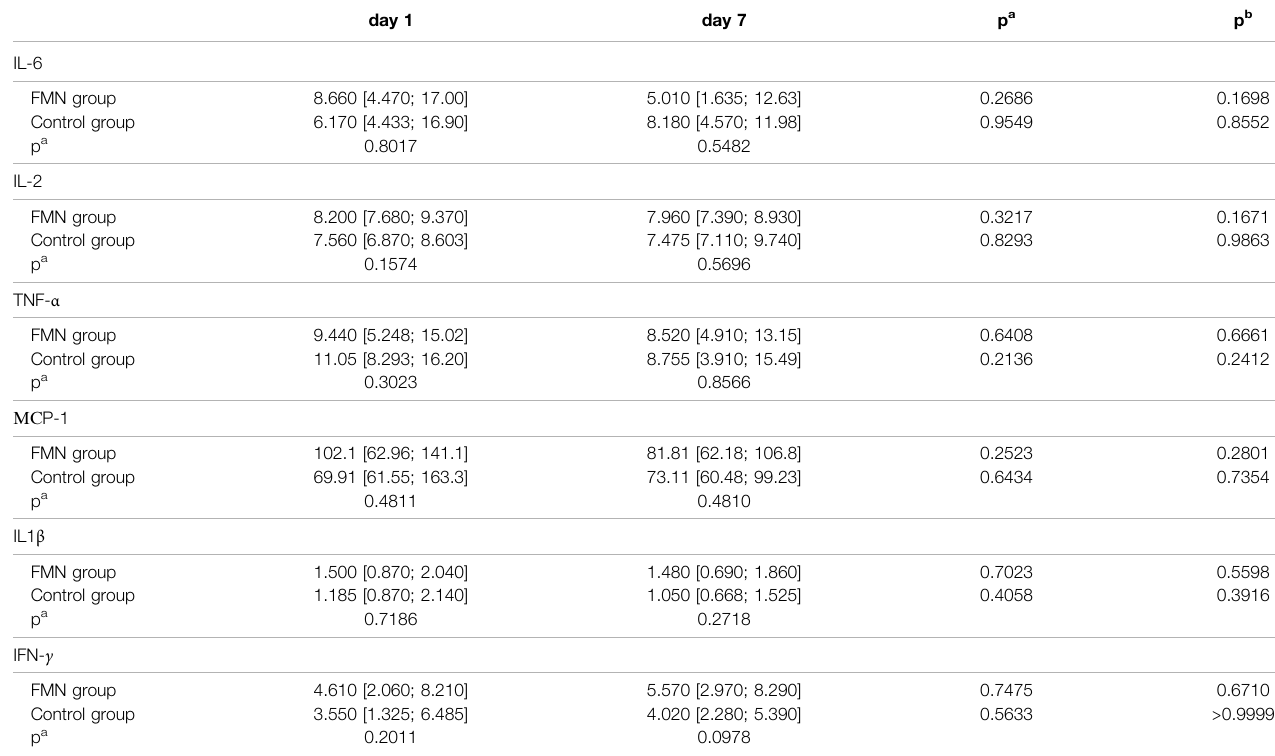
TABLE 6 | Dynamics of cytokines within 1 week after admission to the hospital in FMN group ( n = 30) and control group ( n = 14).